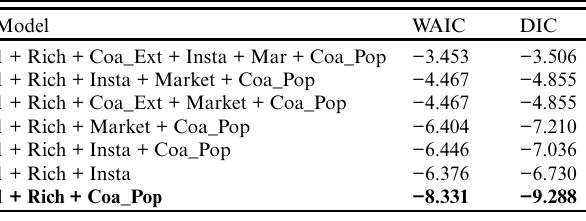
Table 4 . Comparison of the Bayesian models used. Statistical acronyms: DIC, deviance information criterion; WAIC, Watanabe Akaike information criterion. Predictor